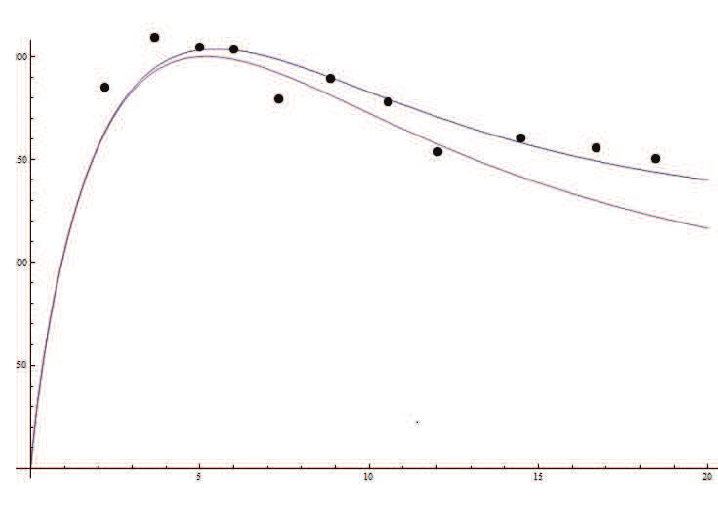
Figure 4. Rotation curve for galaxy NGC 3521.